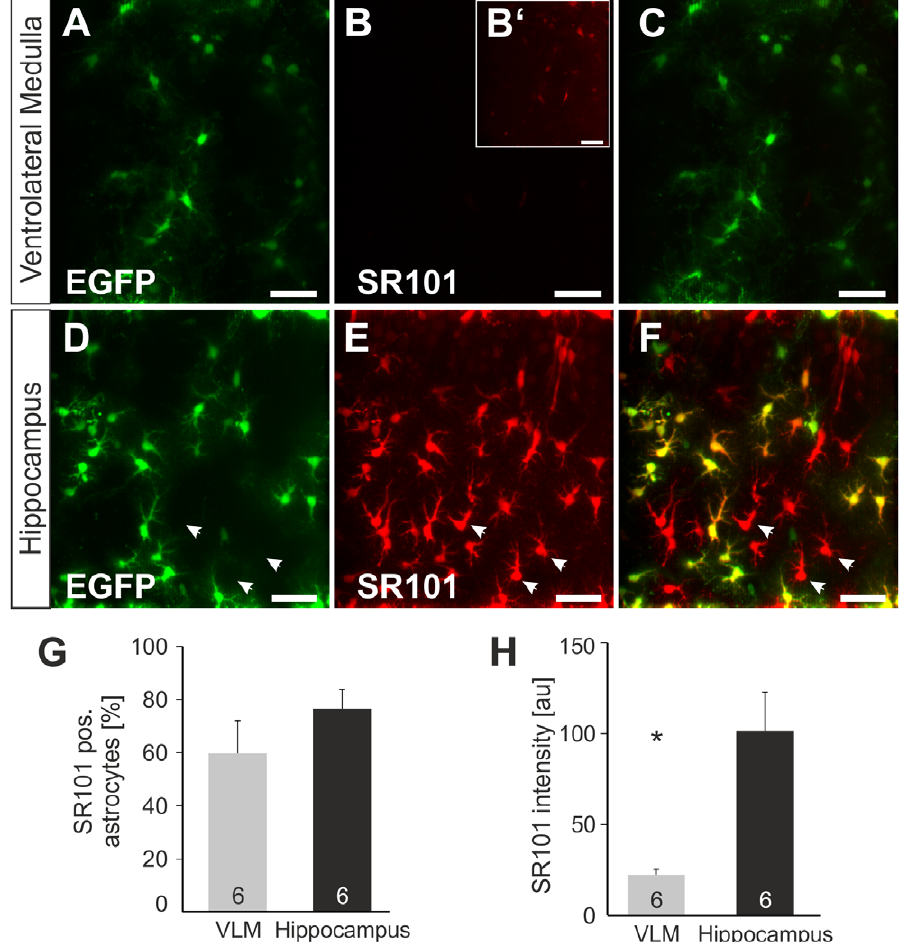
Figure 1. Sulforhodamine 101 labeling in the ventrolateral medulla (VLM) and stratumradiatum (CA1 area) of the hippocampus. A– C: Sulforhodamine (SR101) labeling ( B ) in VLM from transgenic mice expressing EGFP ( A ) under the hGFAP-promotor. B 9 : The overall labeling with SR101 of the VLM is very weak and only visible after increasing image gain. C : Overlay of A and B. D–E: In hippocampal slices, SR101-staining ( E ) largely overlaps with EGFP-labeling ( D ) of astrocytes. ( F ) Overlay of D and E. Images are maximum intensity projections of 21 2P-images, 2 m m distance). Scale bars: 40 m m. G–H: Statistical comparison of labeling of EGFP-astrocytes with SR101 in slices from the VLM and hippocampus. G: Comparison of the percentage of EGFP-positive astrocytes that showed detectable levels of red SR101-fluorescence. H: Comparison of SR101- intensity of EGFP-positive astrocytes. The intensity of SR101 is significantly reduced (asterisk) in the VLM. Error bars=standard error of the mean.